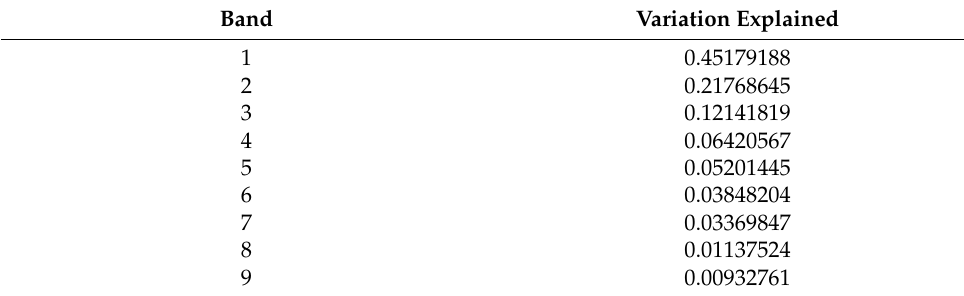
Table A14. TLS PCA band variation explained at 1m grid